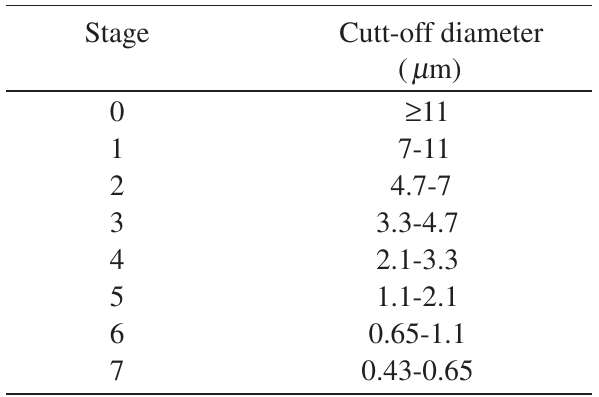
Table I. Cut-off diameters for each single stage of non-viable Andersen Cascade Impactor.